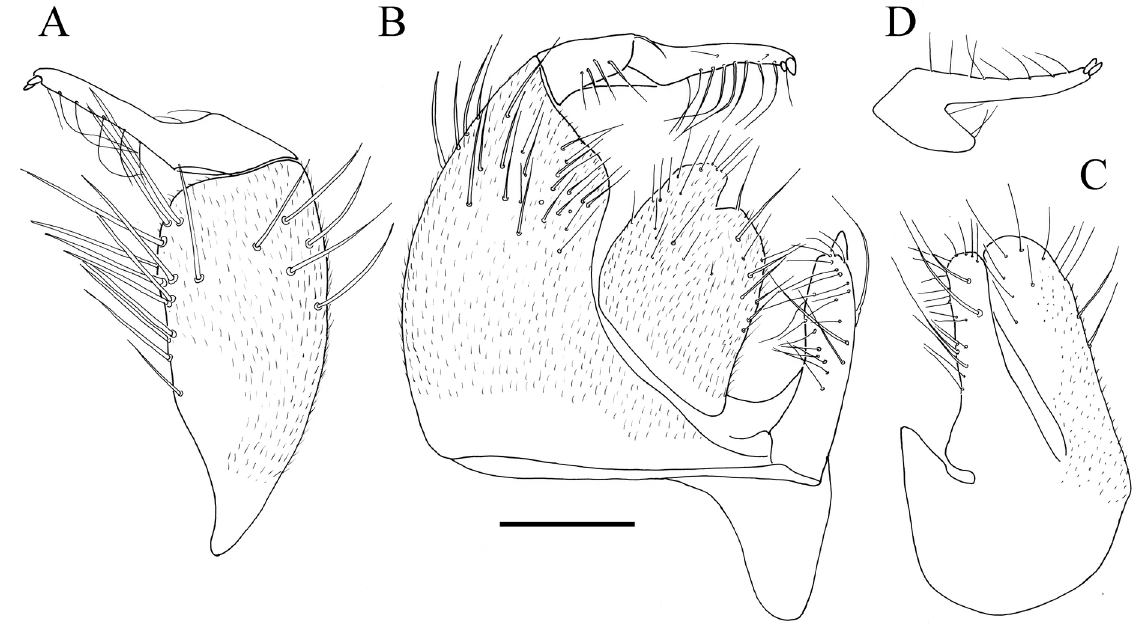
Fig. 11. Terminalia of the topotype of Tachydromia pandellei (Séguy, 1941) from France, Hautes-Pyrénées, Arrens-Marsous, lectotype (RBINS). A . Right surstylus and right epandrial lamella. B . Epandrium with cerci. C . Left epandrial lamella and left surstylus. D . Right surstylus. Scale bar: 0.1